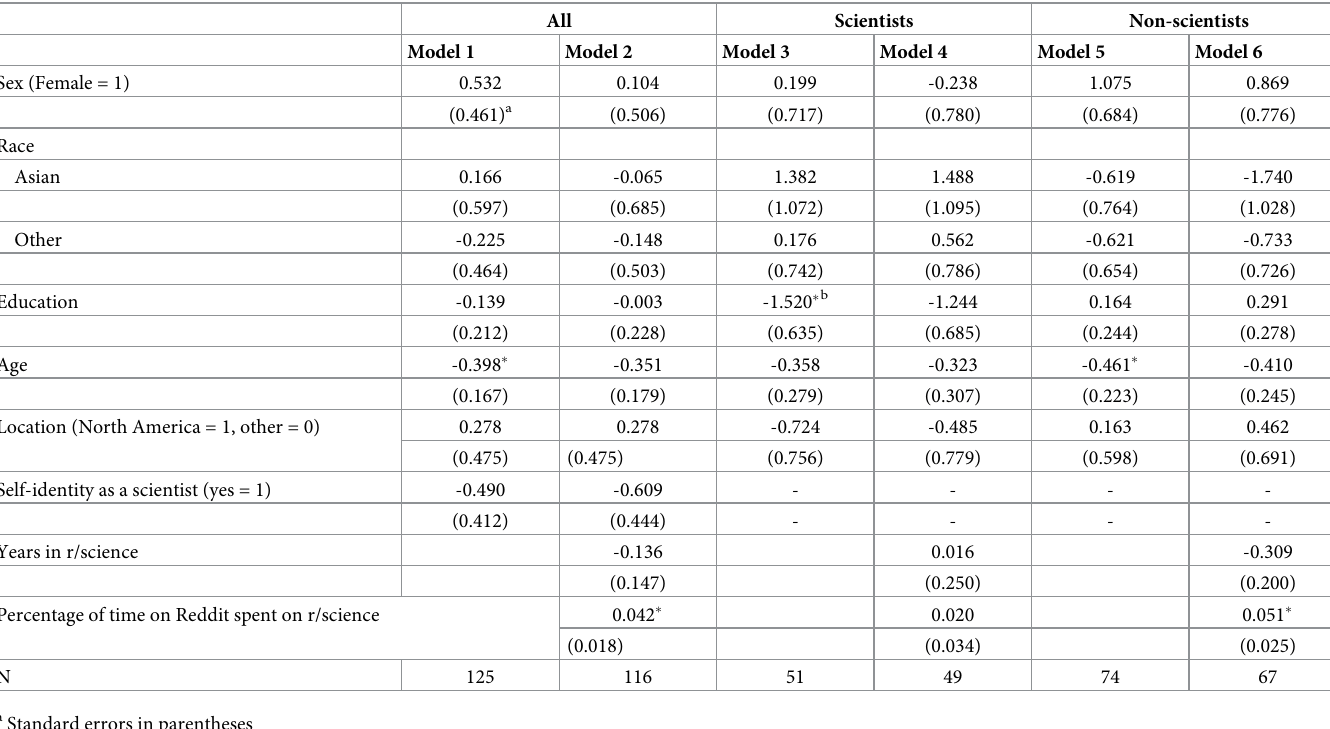
Table 4. Results of ordinal logistic regression of users’ demographics on the perceived effect of helping connect science to their everyday